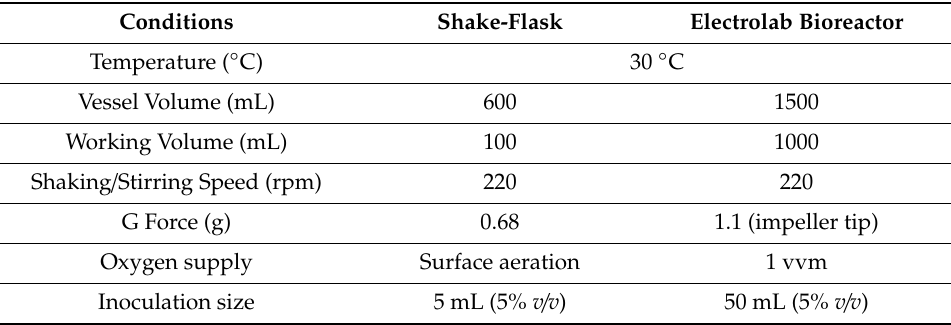
Table 1. Fermentation conditions for all flask- and bioreactor-scale